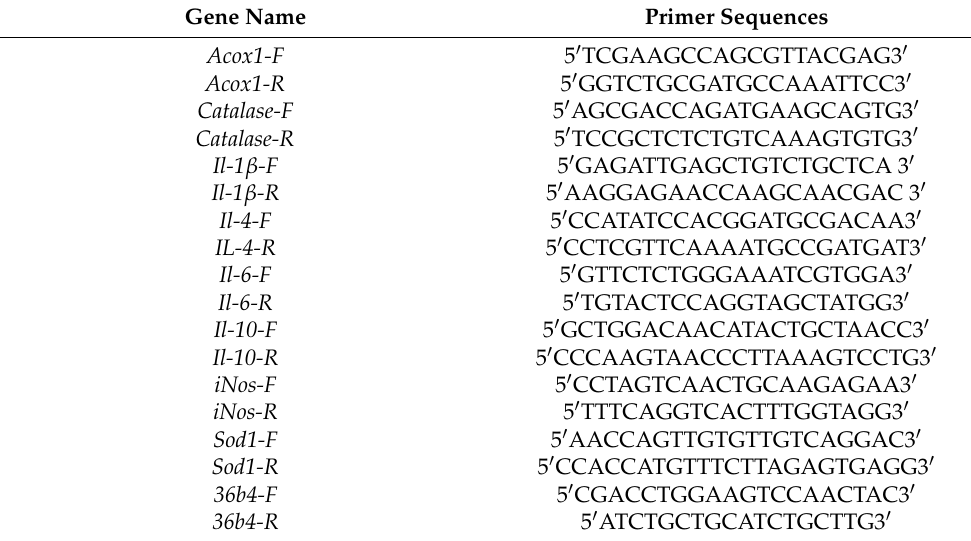
Table 1. Sequences of the primers used for